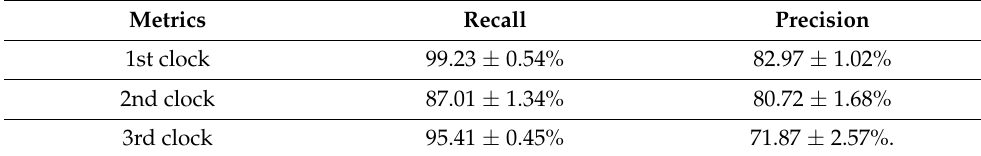
Table 1. Statistical result of valid jump detection.